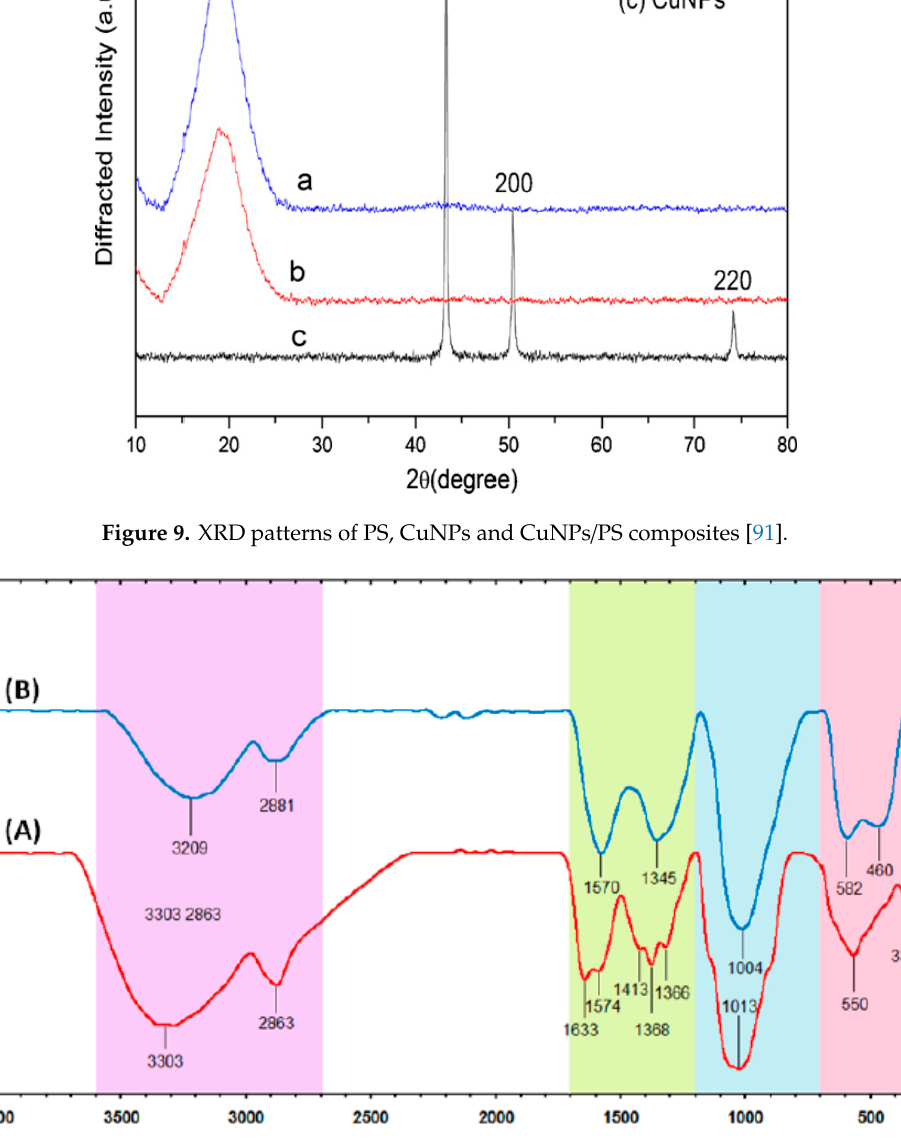
Figure 10. ( A ) Pure chitosan FTIR spectrum and ( B ) fabricated Cu-NPs in chitosan [97].